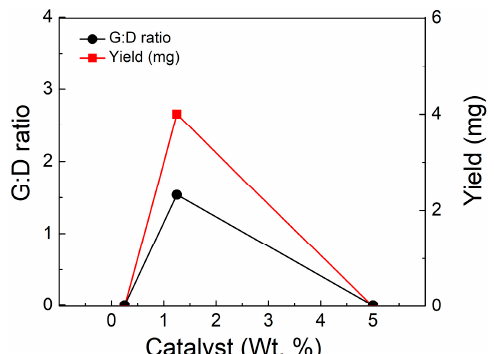
Figure 11. Plot of the Raman G:D ratio (black) and product yield (red) for DLICVD experiments with variable catalyst concentration (wt.%). Experiments were performed with an aspiration temperature of 225 °C, a reaction temperature of 800 °C, an injection rate of 1 mL/h, and EtOH as the carbon source.